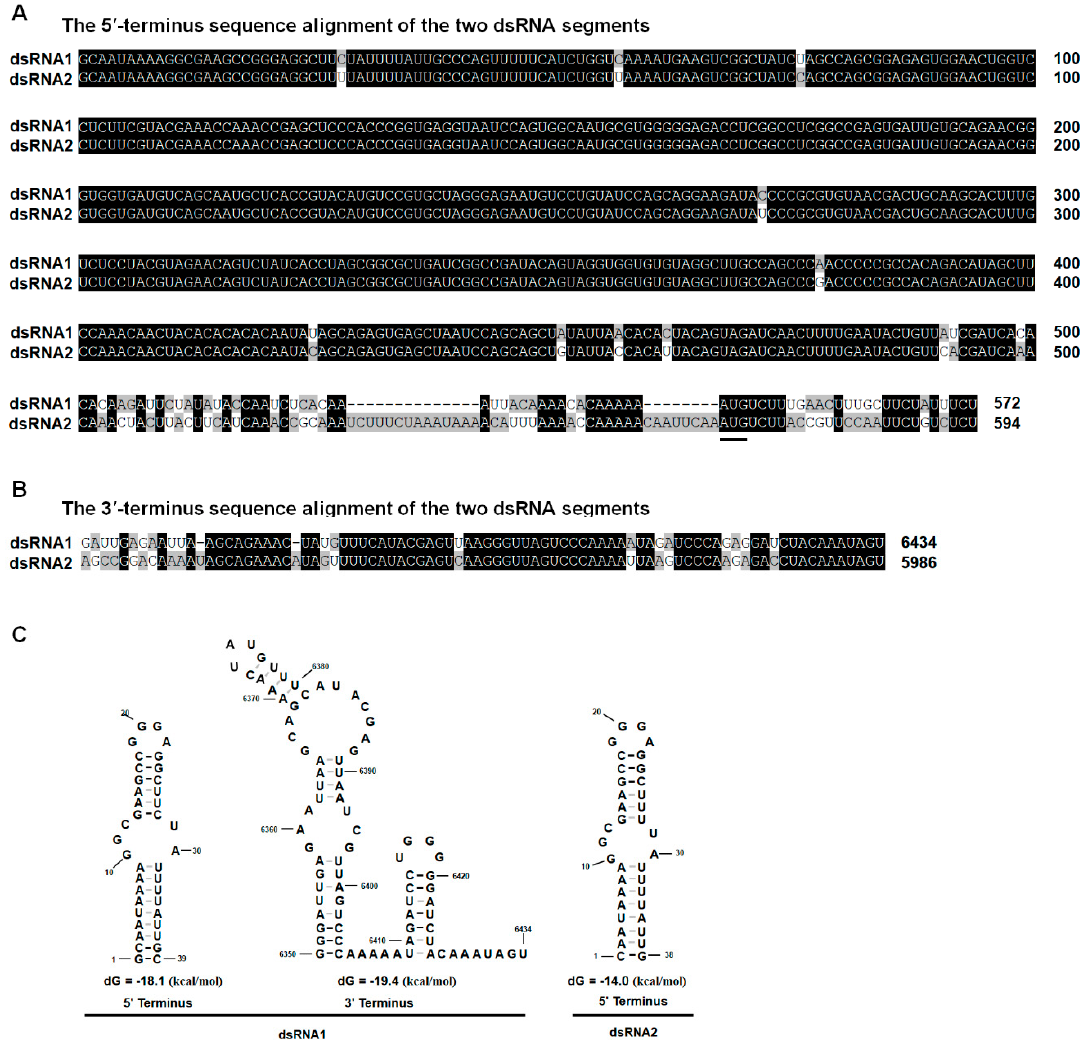
Figure 3. Multiple sequence alignments and predicted secondary structures for the terminal regions of the coding strand of dsRNA1 and dsRNA2. ( A ) Conserved sequences of the 5 ′ -UTRs of dsRNA1 and dsRNA2; ( B ) Conserved sequences of the 3 ′ -UTRs of dsRNA1 and dsRNA2; the conserved sequences are shown in black; ( C ) Predicted secondary structures for the 5 ′ - and 3 ′ -terminus of the coding strands of dsRNA-1 and dsRNA-2 of BmBRV1-BdEW220.